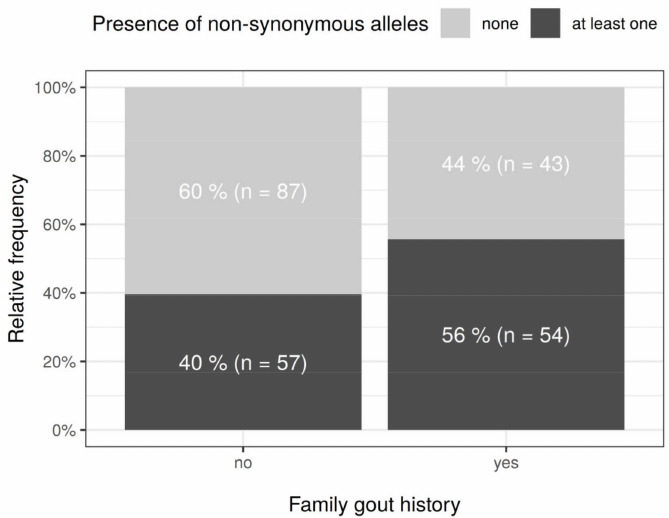
Figure 1. Family history of gout and the numbers of allelic variants in ABCG2 . Depending on the presence or absence of family gout history, proportion of gout patients with or without any of the 11 non-synonymous alleles identified in ABCG2 is summarized. The presence of ABCG2 allelic variants was associated with the gout family history (odds ratio = 1.91, 95% CI: 1.10, 3.34; P = 0.0176, Fisher’s exact